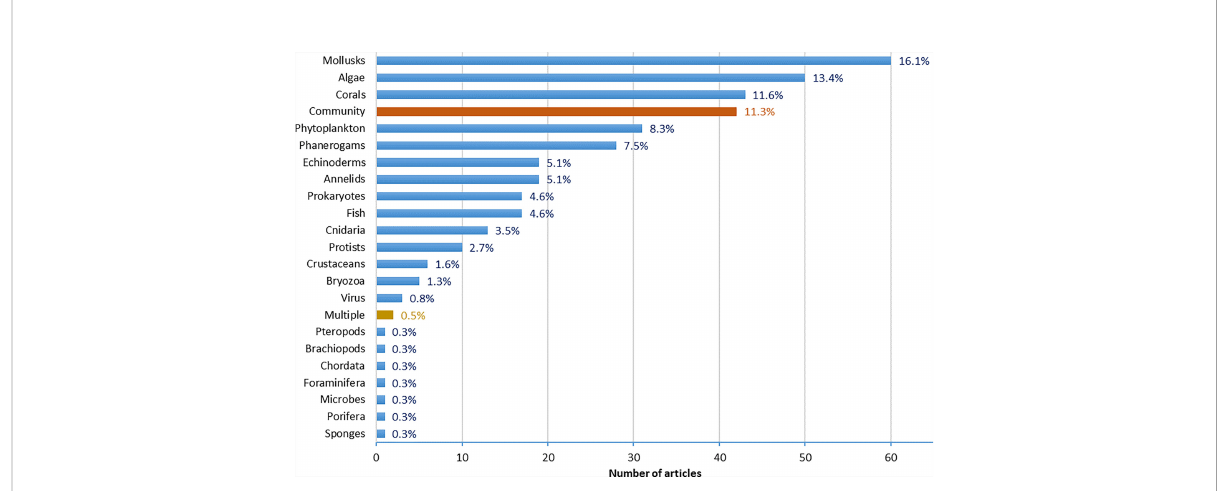
FIGURE 7 Groups of organisms assessed in Mediterranean OA studies. Organisms ’ classi fi cation is based on the OA-ICC